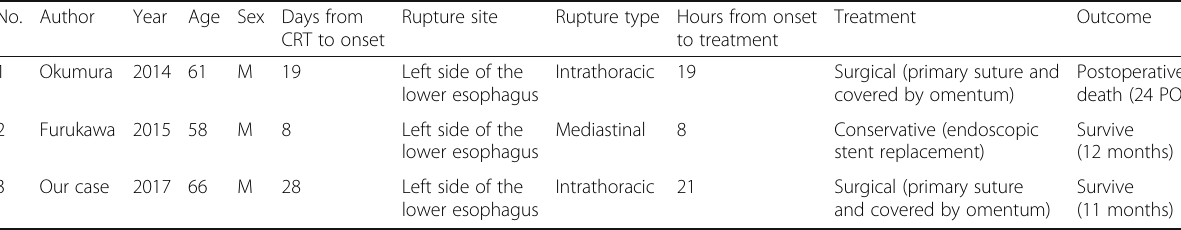
Table 1 Previously reported cases of Boerhaave syndrome during CRT No.